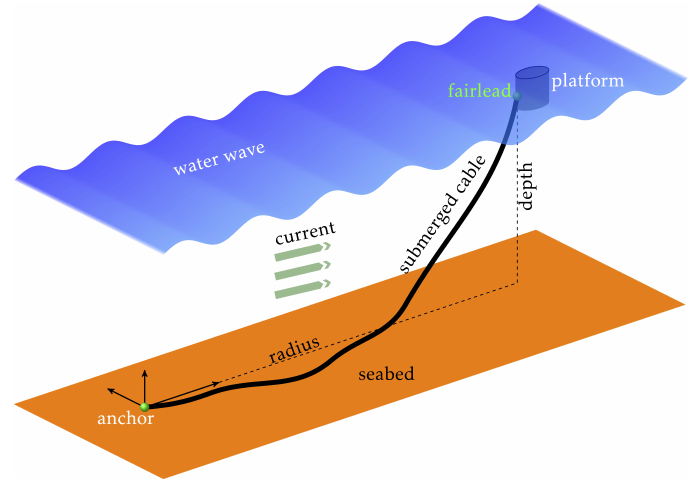
Figure 5. Submerged cable subjected to wave and current [30].